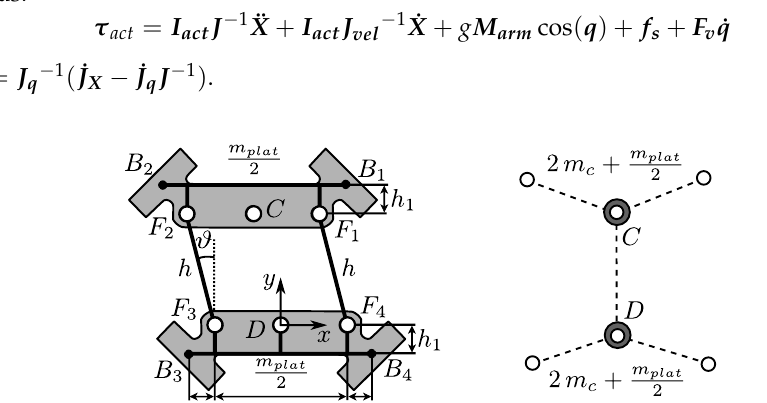
Figure 3. Model of the mobile platform.